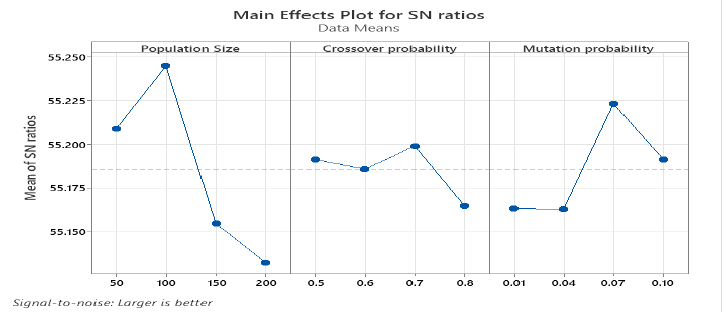
Fig. 8. S/N ratio plot obtained from Taguchi method